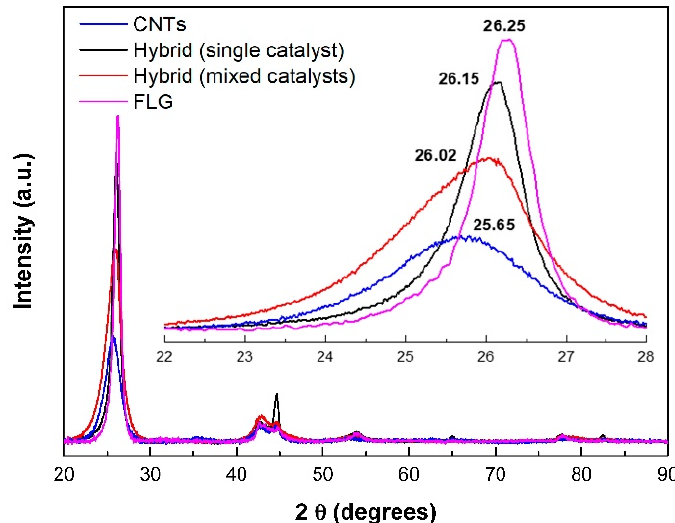
Figure 4. Powder X-ray diffractograms of pure CNTs and FLG, together with those of FLG–CNT hybrids obtained from a single catalyst and from a mixture of CNT and FLG catalysts. Inset shows the (002) peak for all the samples.